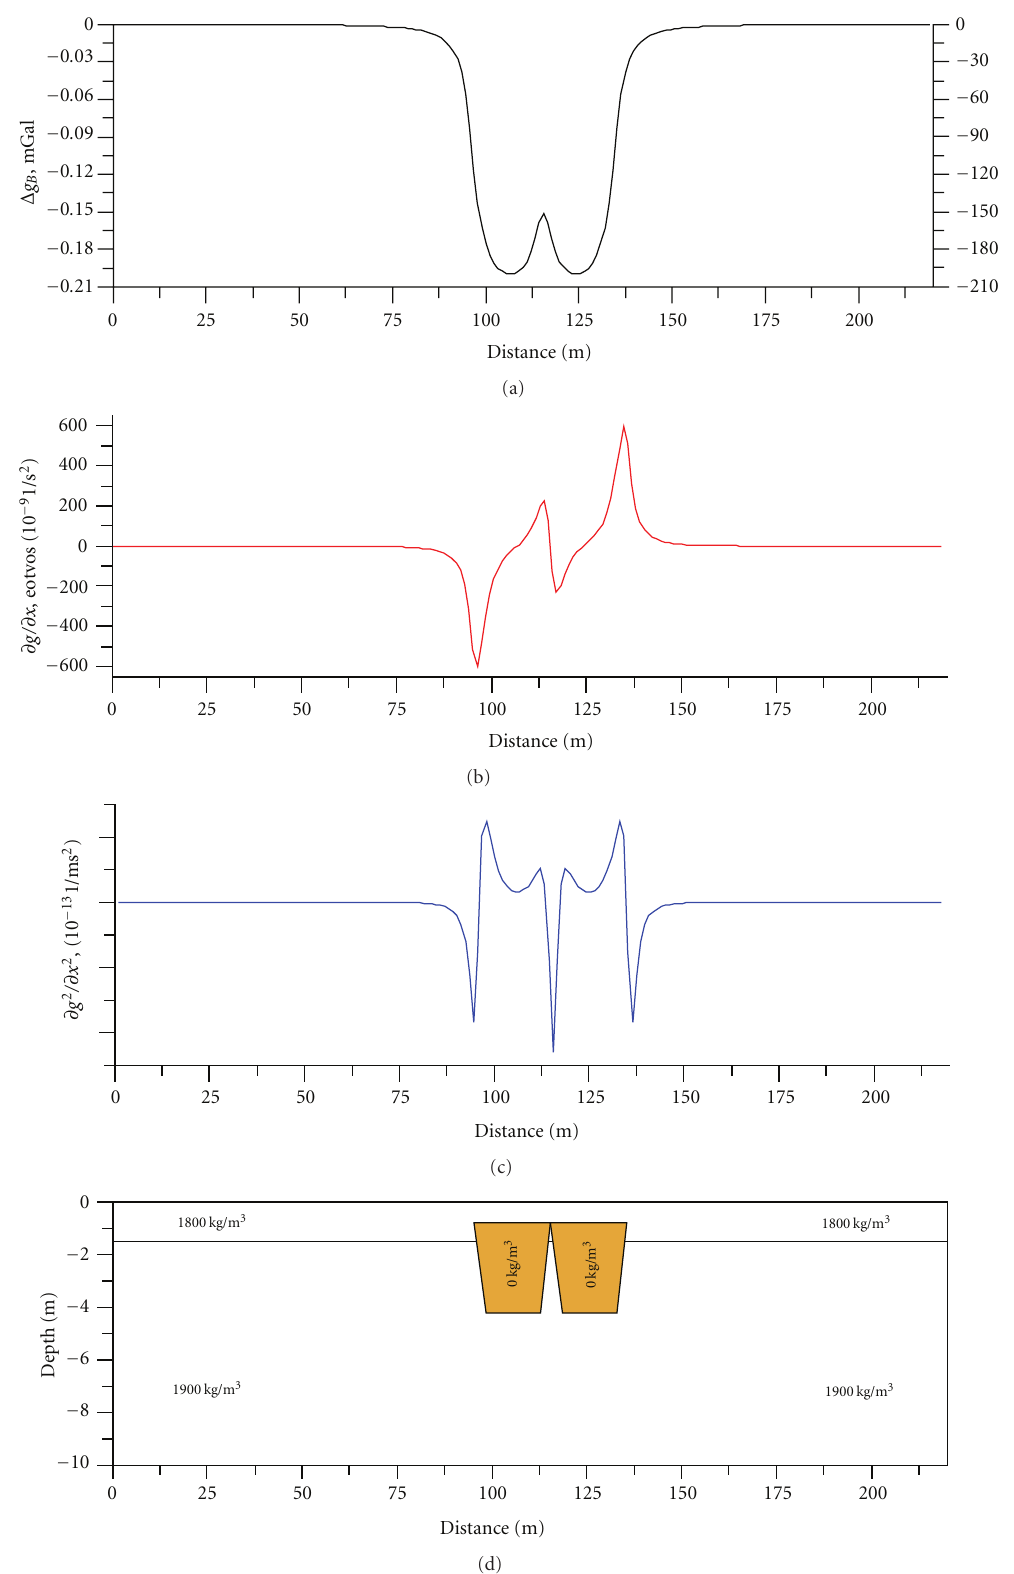
Figure 5: Computing of horizontal derivatives from models of two closely disposed caves. (a) computed gravity curve, (b) calculated first horizontal derivative of gravity field Δ g x , (c) calculated second horizontal derivative of gravity field Δ g xx , and (d) physical-geological